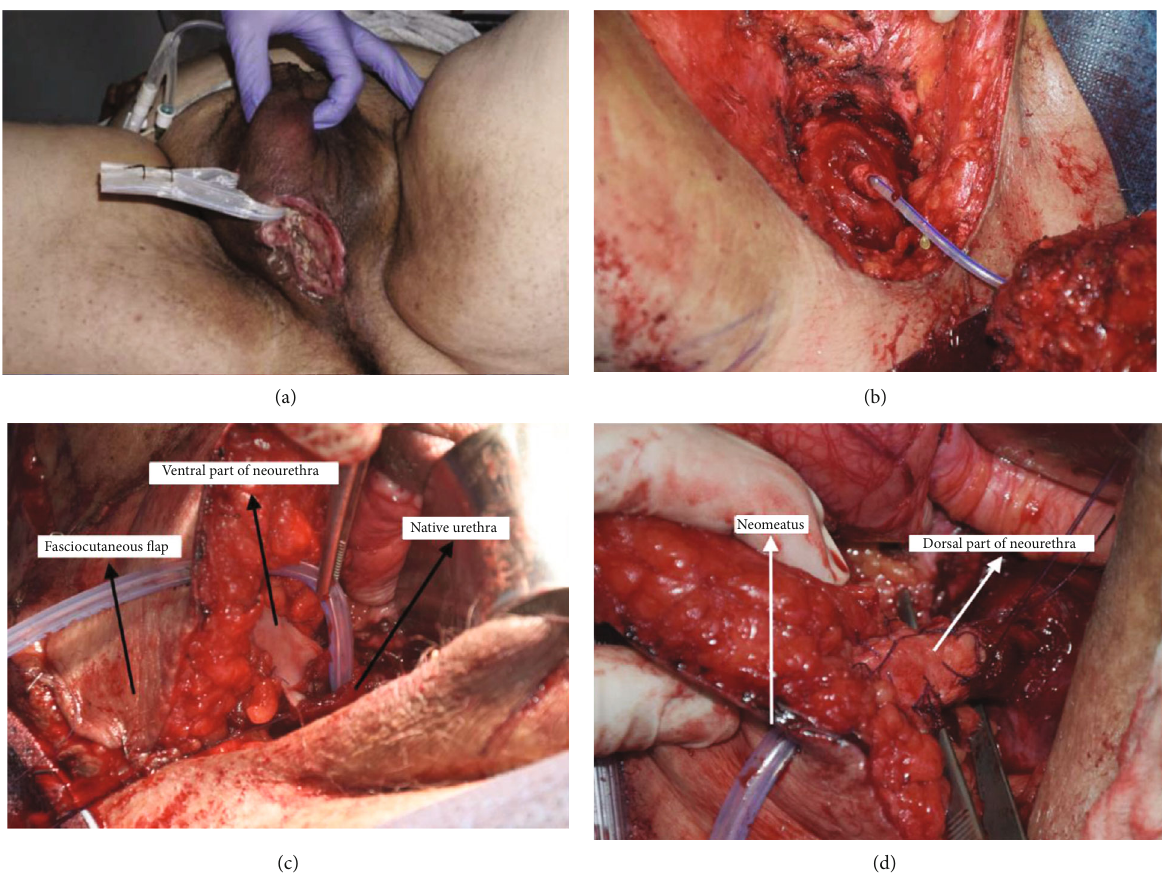
Figure 2: En-bloc excision of carcinoma and reconstruction of perineal defect. (a) Perineal wound indurated on palpation with drainage of purulent material. (b) En-bloc excision of tumor tissue. The prostatic apex can be seen. (c) Ventral side of neourethra. (d) Double buccal mucosa tubular graft. The neourethra is passed through the fasciocutaneous fl